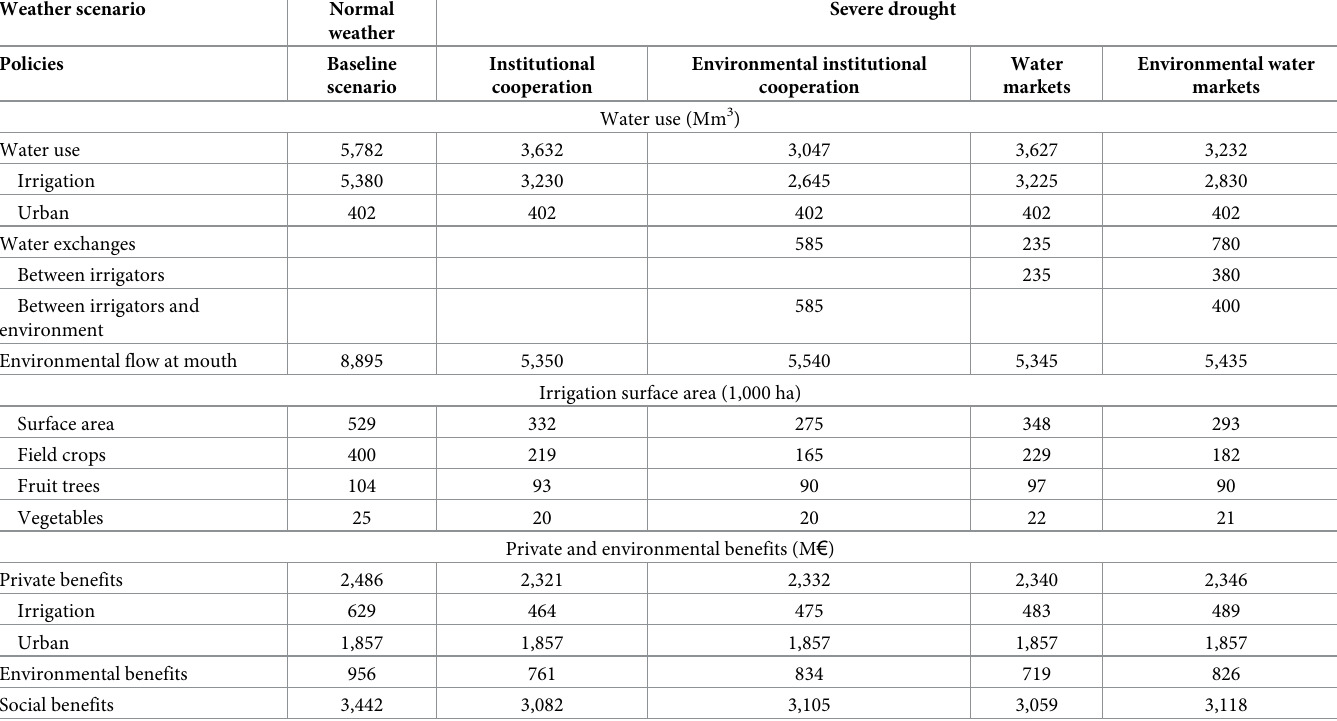
Table 2. Policies under drought conditions: Institutional cooperation, environmental institutional cooperation, water markets, and environmental water markets.